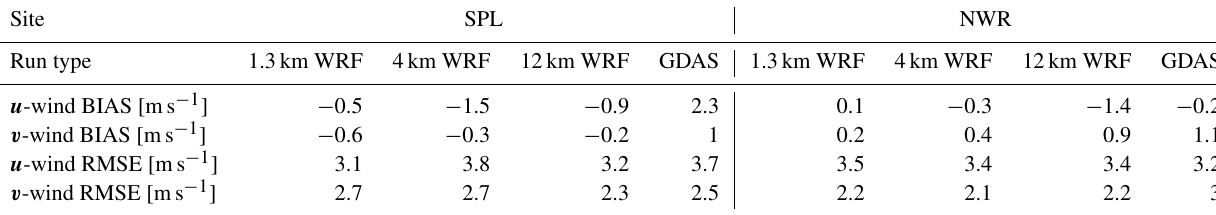
Table 2. Comparisons of different meteorological files driving STILT against hourly averaged wind observations at the Storm Peak Lab- oratory ( − 106 . 74 ◦ W; 40.45 ◦ N) and at Niwot Ridge ( − 105 . 586 ◦ W; 40.053 ◦ N; 3502ma.s.l.; Knowles, 2015), near the RACCOON CO 2 site. Meteorological observations were not available at the Hidden Peak site. Error statistics are presented separately for the west-to-east component (“ u -wind”) and south-to-north component (“ v -wind”) of the wind velocity vector. Site SPL NWR Run type 1.3km WRF 4km WRF 12km WRF